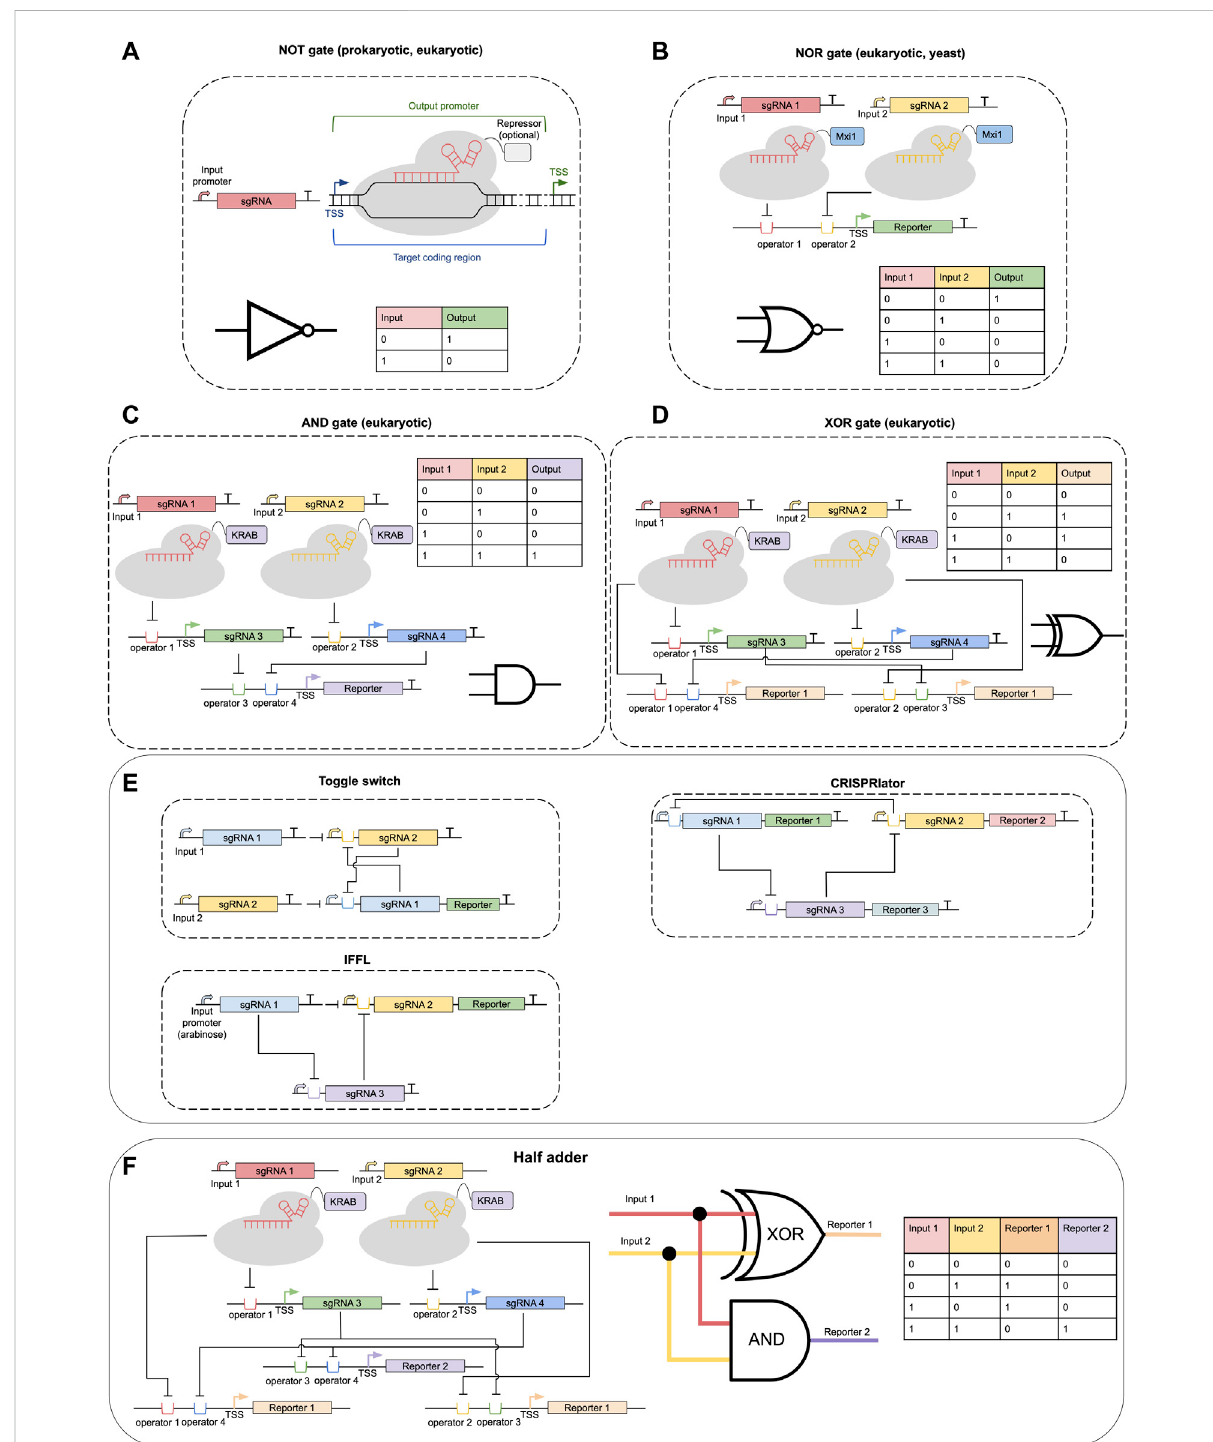
FIGURE 2 CRISPR-dCas-basedgeneticcircuits. (A) ANOTgatebasedonCRISPRiapproach. (B) AtypicalNORgateineukaryotesbuiltwithdCas9fusedto a Mxi1 chromatin repressor domain. (C) A variant of AND gate based on the CRISPRi approach. (D) A variant of XOR gate based on the CRISPRi approach. (E) Simple genetic circuits: toggle switch, incoherent feed-forward loop, CRISPRlator. (F) A two-layer CRISPR-dCas-based circuit implementing a half-adder device. Where appropriate truth tables and schematic representations of logic gates are